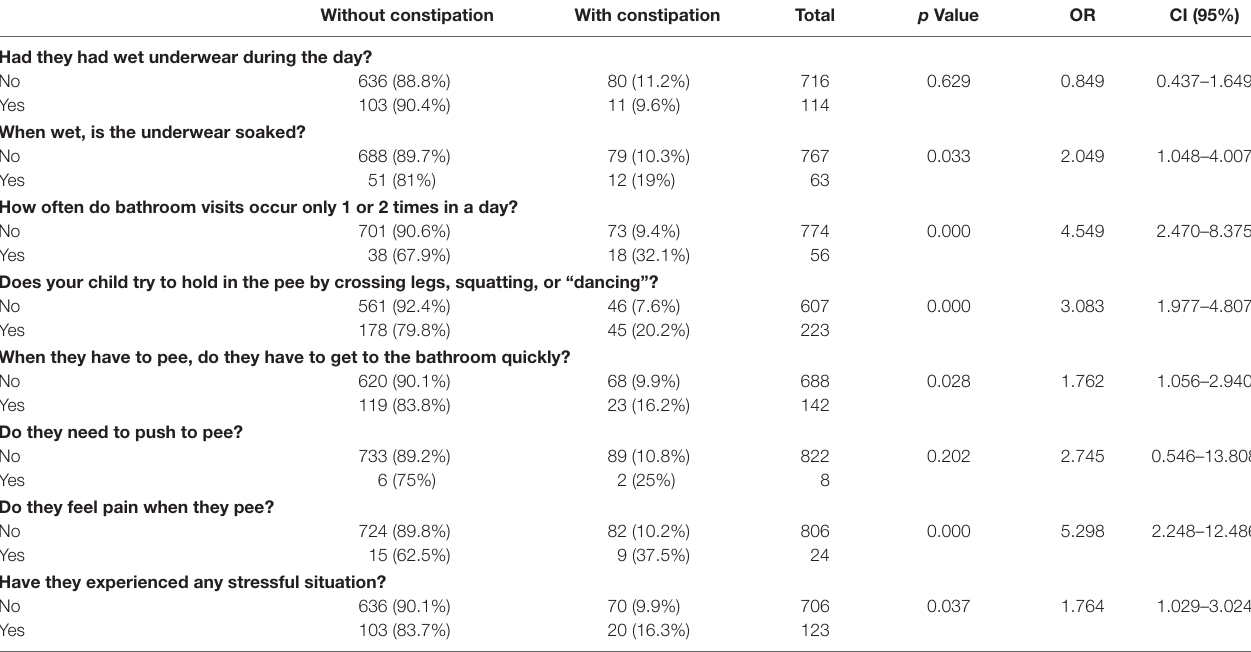
TaBle 2 | Presence of urinary symptoms, according to DVss in constipated and non-constipated